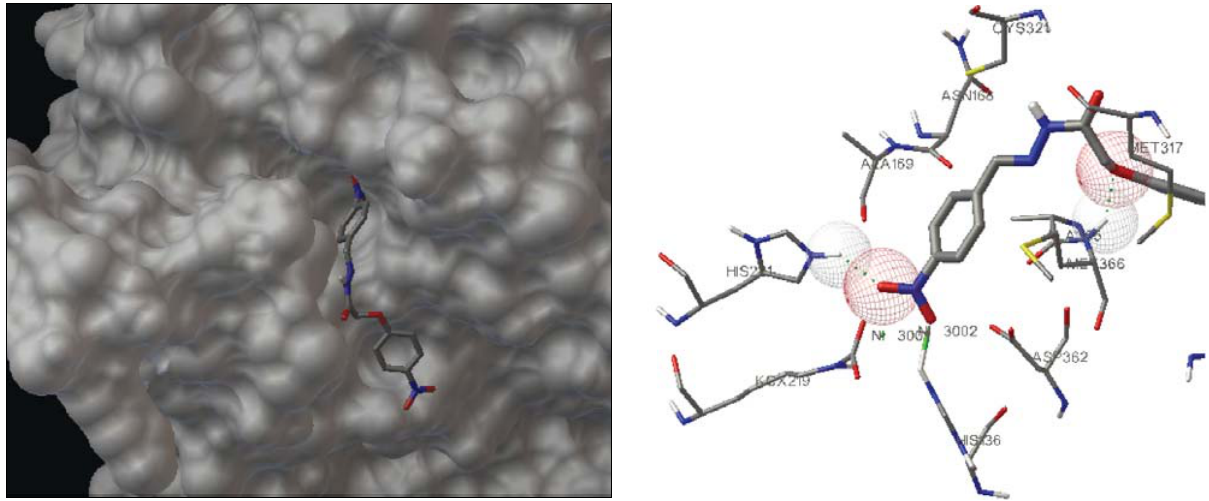
Figure 6. Binding mode of compound 2 with H. pylori urease. The enzyme is shown as surface, and molecule of 2 is shown as sticks (left). The hydrogen bonds are displayed as dashed lines